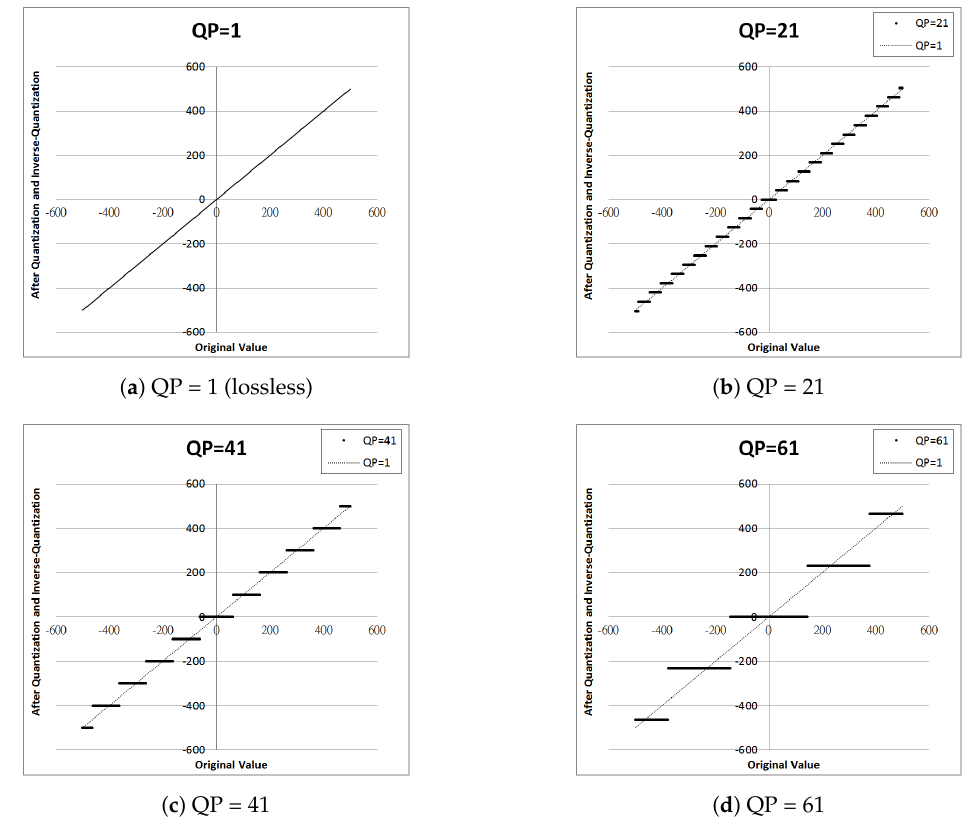
Figure 3. Lossless (QP = 1) and lossy (QP > 1) quantization.